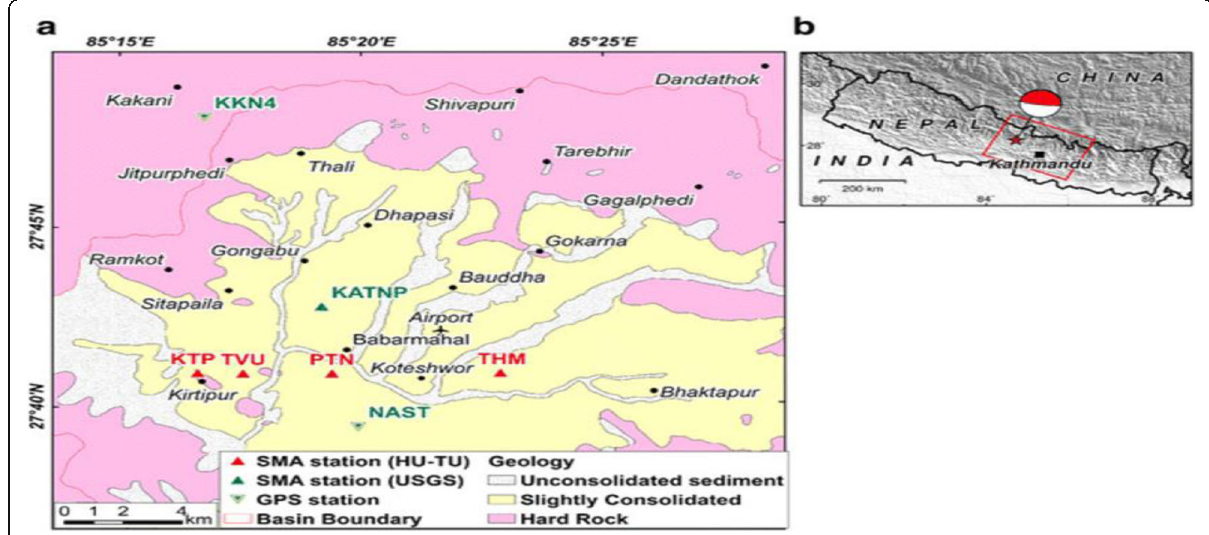
Fig. 3 “ a ” and “ b ” shows Kathmandu Basin as well as the location of strong-motion seismometers (Shrestha, et al.